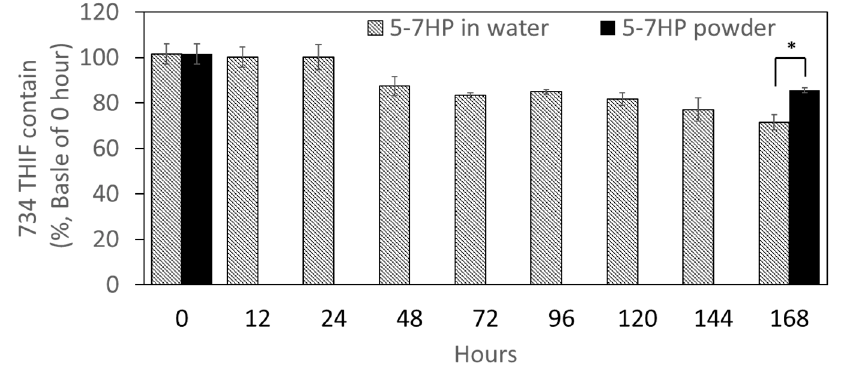
Figure 6. The photostability of 5-7HP powder and 5-7HP water solution. Values are mean ± SD ( n = 4). * p < 0.05.